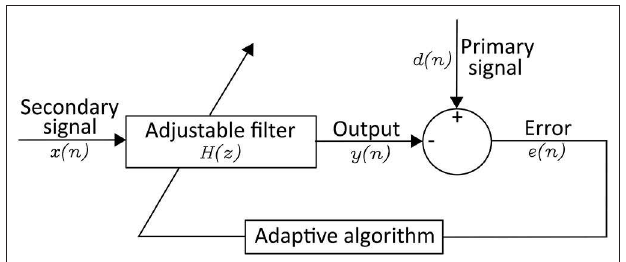
FIGURE 4 | Structure of an Linear Adaptive